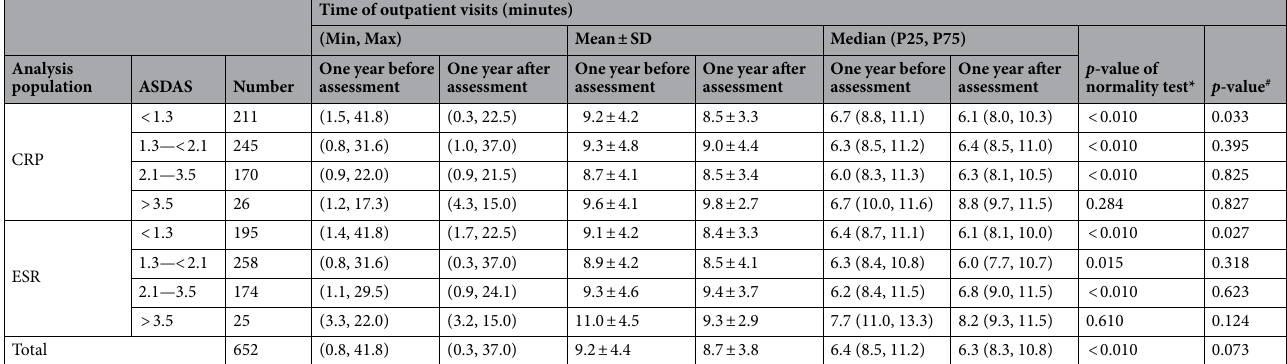
Table 3. Time of outpatient visits before and after the first EMRMS assessment (n = 652). *Normality test: When number is ≤ 50, the Shapiro–Wilk test is used; when number is > 50, the Kolmogorov–Smirnov test is used. # When normality test p value is > 0.05, the pair -t test is used; when normality test p value is < 0.05, the Wilcoxon Signed Rank test is used. Abbreviations: ASDAS Ankylosing Spondylitis Disease Activity Score, CRP C-reactive protein, ESR Erythrocyte sedimentation rate.